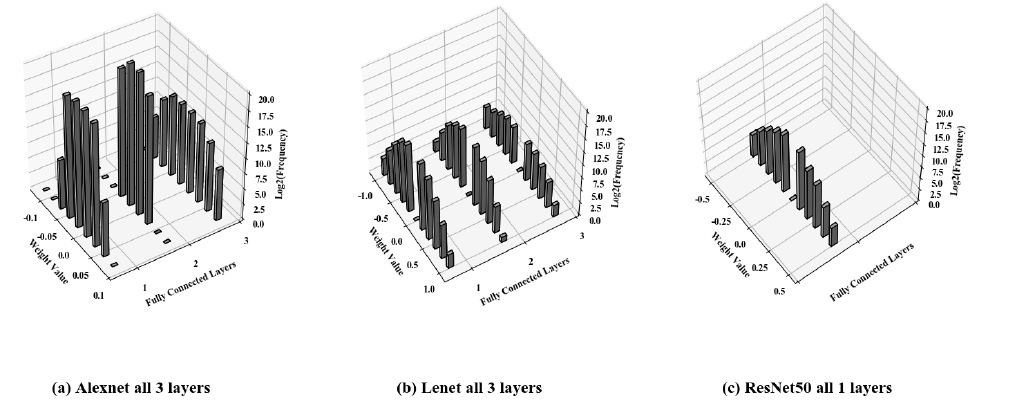
Figure 5. Histograms to demonstrate the symmetric nature of the weight distribution in fully connected layers on